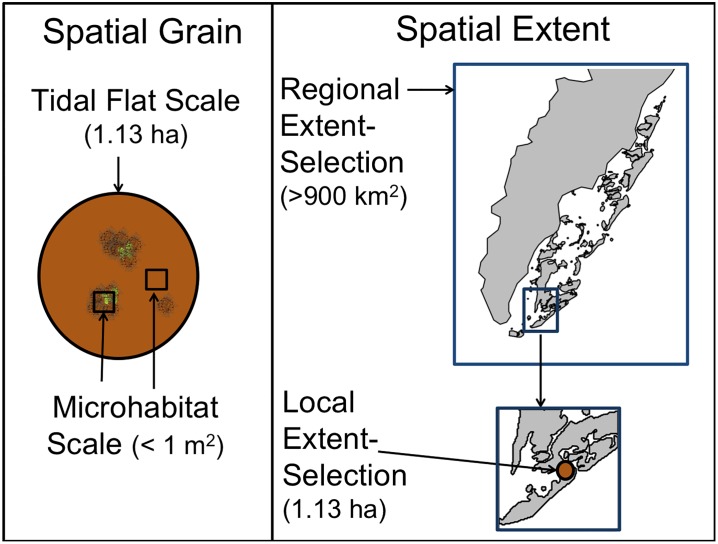
Schematic of spatial scales analyzed.Left side shows spatial grains (tidal flat vs. microhabitat), with the brown circle depicting a circular tidal flat plot. The right side shows spatial extent (regional vs. local) with land in gray and water in white. Relative areas shown in parentheses.